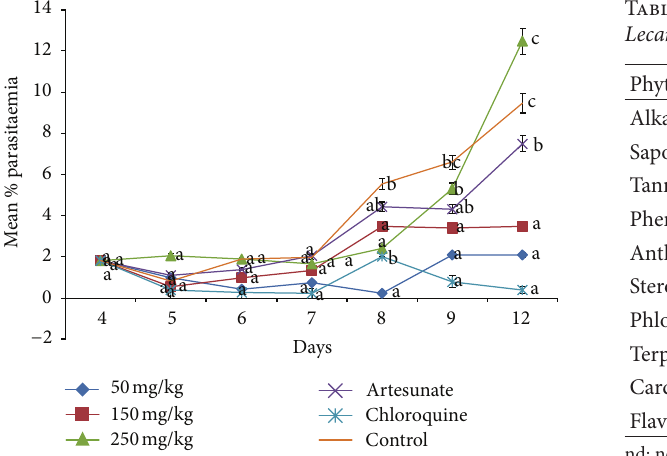
Figure 1: Parasitaemia changes following treatment with different doses of aqueous extract of Lecaniodiscus cupanioides and standard drugs. Values carrying different superscript from the control are significantly different ( 𝑃 < 0.05 ).